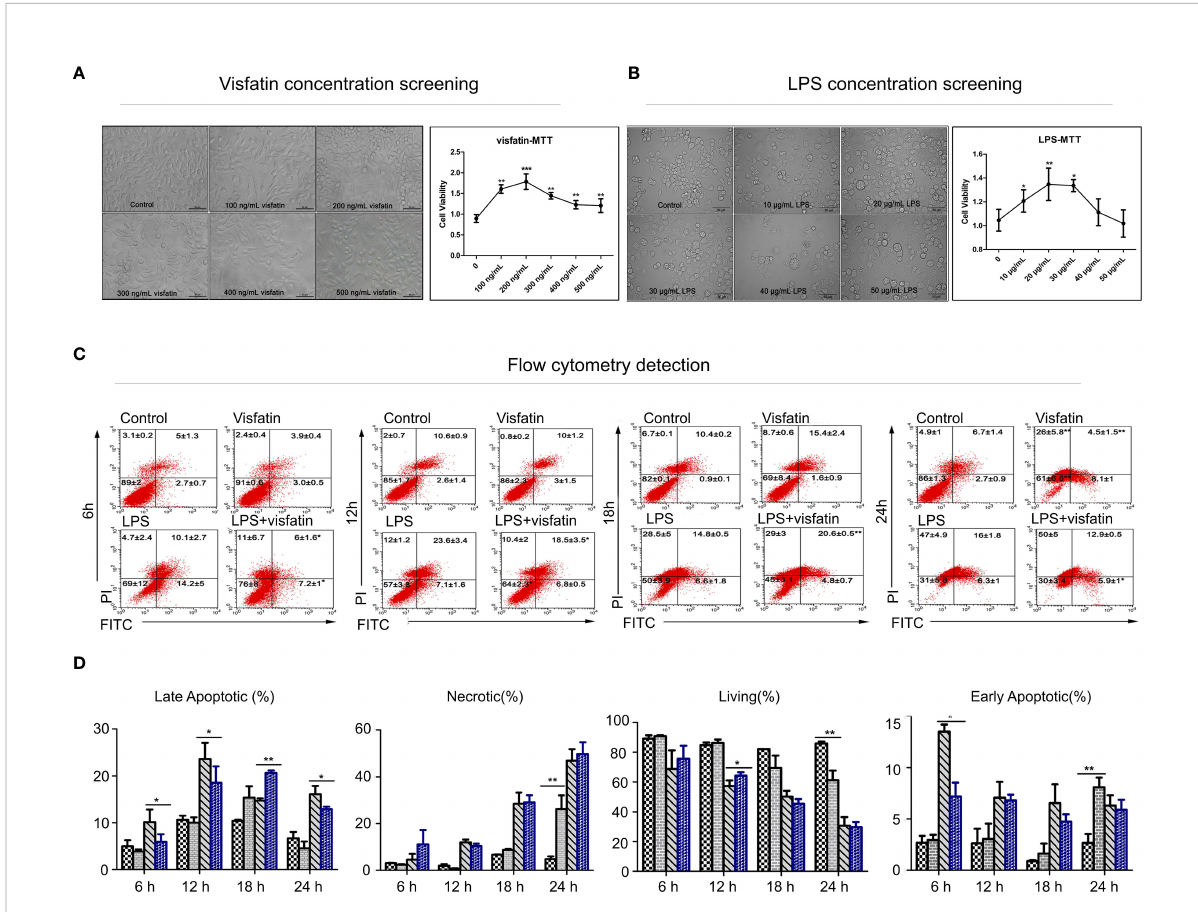
FIGURE 1 Effects of visfatin on cell proliferation and apoptosis in RAW264.7 cells. (A) Screening of the optimal dose of visfatin acting on RAW264.7 cells (** P <0.01). RAW264.7 cells were treated with numerous concentrations of visfatin for 24 h, and the viability was assessed by MTT assay. (B) Screening of the optimal dose of LPS stimulated RAW264.7 cells (* P <0.05, and ** P <0.01). RAW264.7 cells were treated with numerous concentrations of LPS for 24 h, and the viability was assessed by MTT assay. (C) Flow cytometry to detect the role of visfatin in different stages of cell apoptosis (* P <0.05, and ** P <0.01). RAW264.7 cells were treated with visfatin, LPS, and LPS+visfatin for different time intervals from 6 h to 24 h. (D) The ratios of live, early apoptotic, late apoptotic, and necrotic cells after exposure to visfatin, LPS, and LPS+visfatin for various time